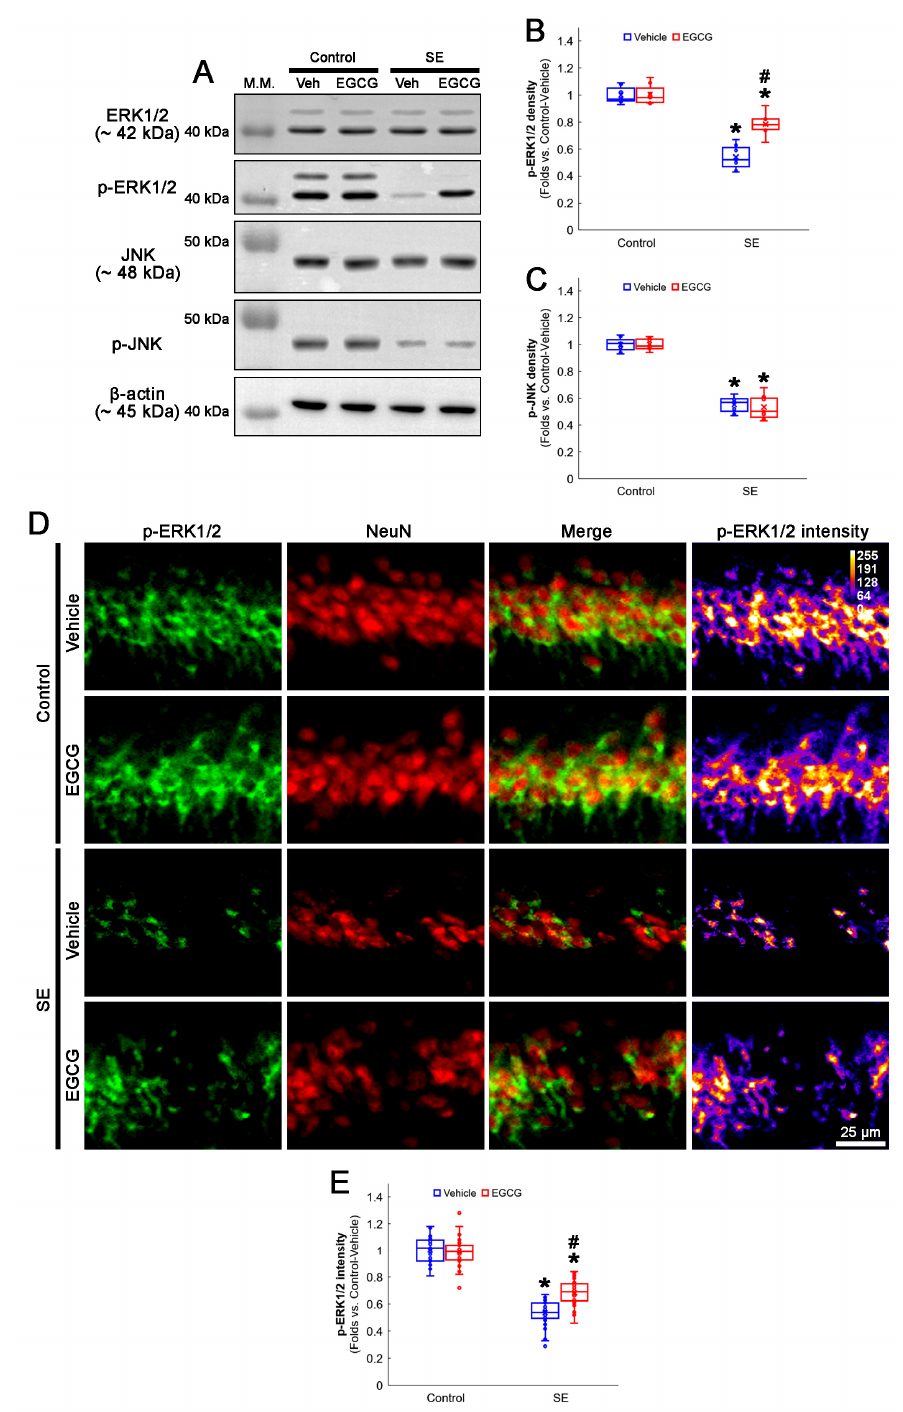
Figure 6. Effects of EGCG on ERK1/2 and JNK activities following SE. Western blot data showed that ERK1/2 and JNK phosphorylation decreased in SE group without affecting their total protein levels. In control animals, EGCG did not affect ERK1/2 and JNK phosphorylation. EGCG attenuated decreased ERK1/2 but not JNK phosphorylation in SE group ( A – C ). Immunofluorescent study revealed that ERK1/2 phosphorylation was reduced in CA1 neurons of SE group, compared with control animals. In control animals, EGCG did not affect ERK1/2 phosphorylation in CA1 neurons. EGCG attenuated a decrease in ERK1/2 phosphorylation in the CA1 neurons ( D , E ) of SE group. ( A ) Representative Western blot of ERK1/2, JNK and their phosphorylation in the whole hippocampus. ( B )